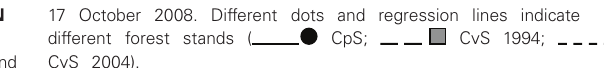
17 October 2008. Different dots and regression lines indicate different forest stands ( CpS; CvS 1994; CvS